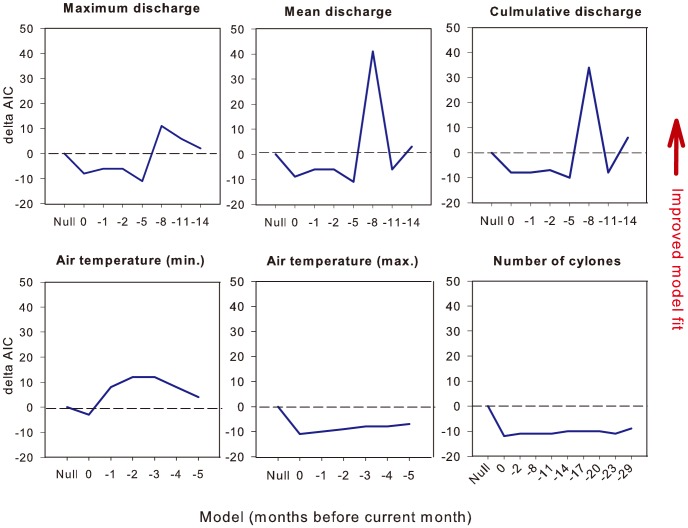
Fit of different additive models of dugong natural mortality as a function of lagged environmental predictors, at lags from zero (same month) up to 29 months (-29).In each case predictors are compared to the null model, which includes only the random effects and time-series component. Delta AIC represents the difference in predictive power between the null model and the model in question (higher values represent improved model fit).